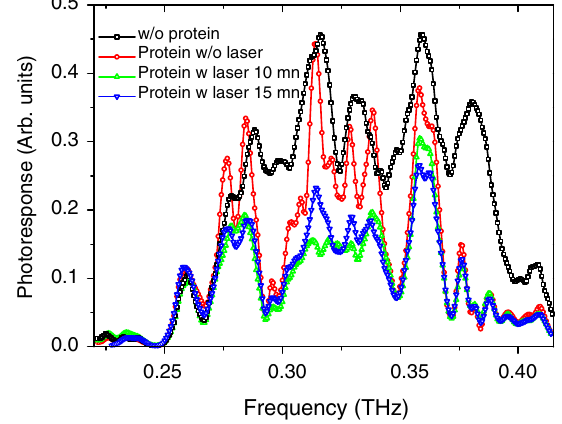
FIG. 8. Raw data of the rectenna-based absorption spectra. Black squares correspond to the THz emitting source spectrum without the protein solution. Red circles correspond to the absorption spectrum of the BSA protein solution without blue light illumination. Green triangles correspond to the absorption spectrum of the BSA protein solution recorded after 10 min of blue light illumination. Blue triangles correspond to the absorp- tion spectrum of the BSA protein solution recorded after 15 min of blue light illumination. BSA concentration is equal to 1 mg =